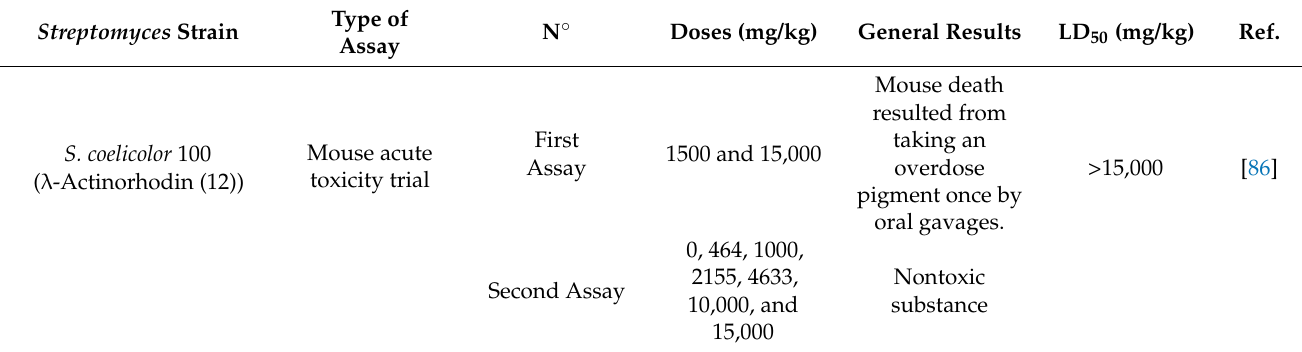
Table 12. LD 50 of Streptomyces -derived pigments and the in vivo